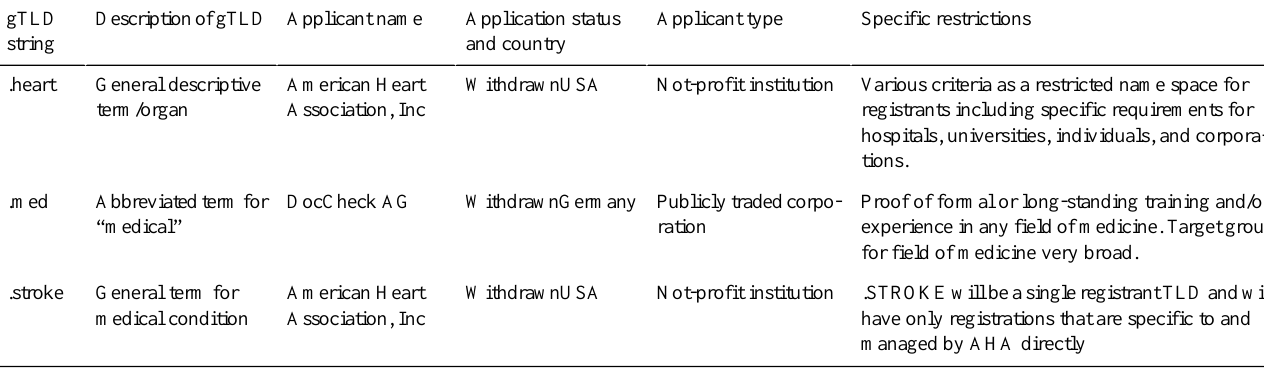
Table 4. Examples of withdrawn